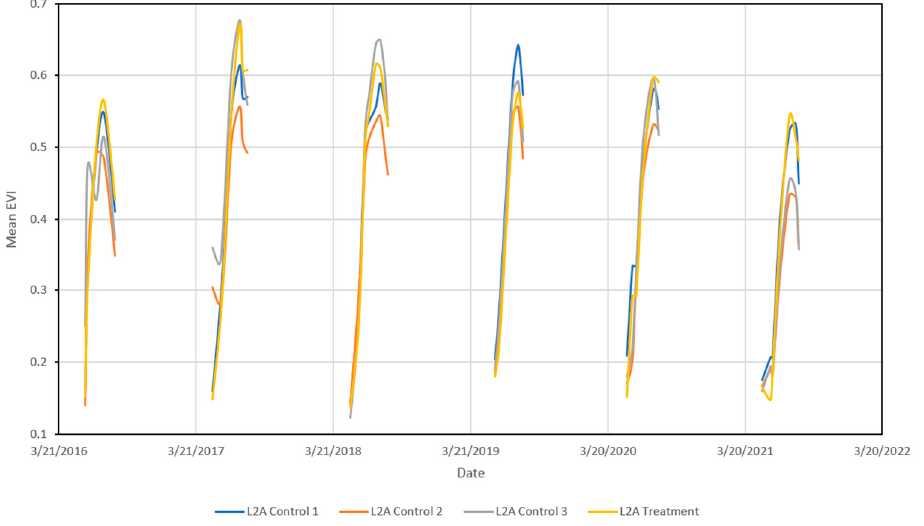
Figure 8. Sentinel-2 (May to August, 2016–2021) mean EVI values (level-2A, dimensionless) for treatment and control reaches.